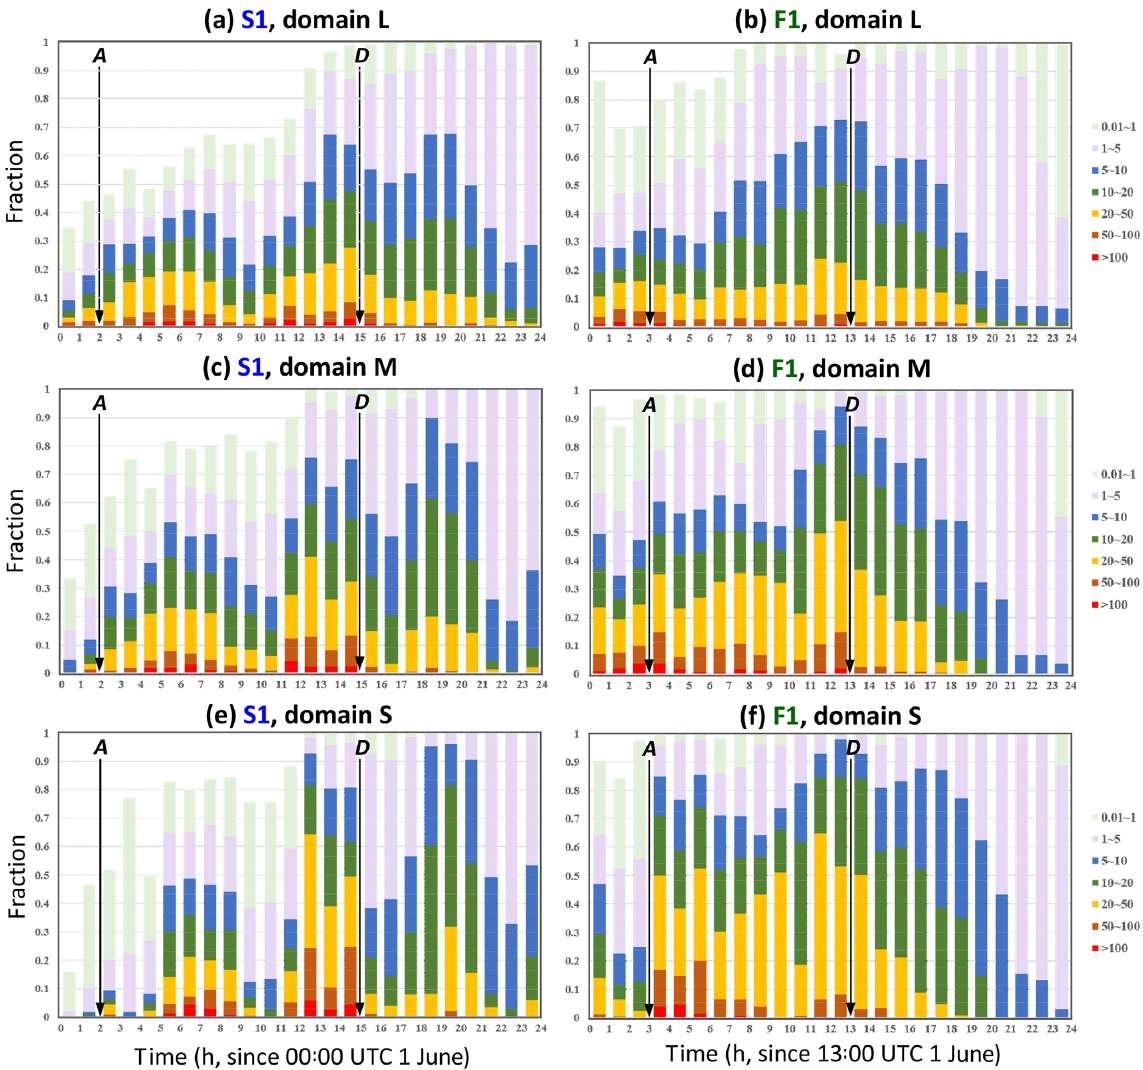
Figure 10. Fractional distributions of different rain rate ranges (mmh − 1 , see legend) inside the large (L) domain (24.85–25.65 ◦ N, 120.75– 122.15 ◦ E) in experiment (a) S1 and (b) F1, respectively, during their selected 24h period (starting from 00:00UTC on 1 June for S1 and 13:00UTC on 1 June for F1). (c–f) As in (a) , (b) , except for (c) , (d) the middle (M) domain (25.05–25.45 ◦ N, 121.1–121.8 ◦ E) and (e) , (f) the small (S) domain (25.1–25.3 ◦ N, 121.35–121.8 ◦ E), respectively. The three domains are shown in Fig. 9, and the arrival (A) and